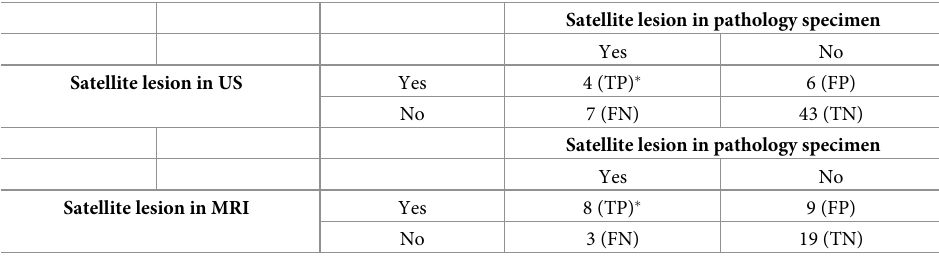
all modalities, underestimating lesion sizes in 38.3% of patients (mean underestimation of 4.5mm). This was similarly noted in several studies which showed significant size Table 3. True positive (TP), true negative (TN), false positive (FP) and false negative (FN) in US and